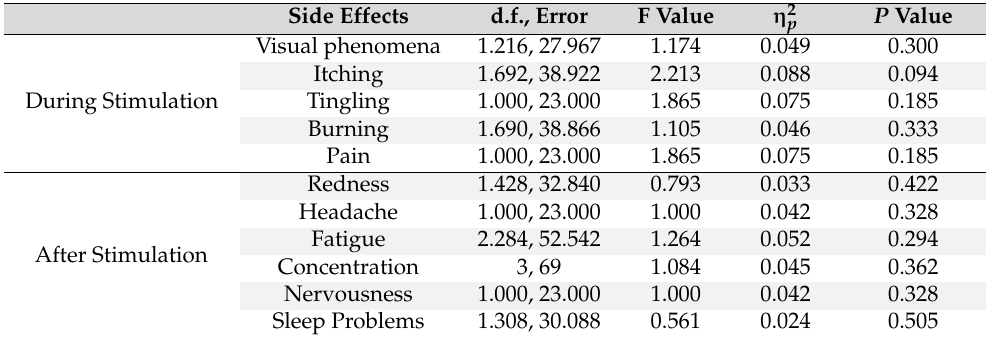
Table 5. Side effect ratings of the participants, ANOVA results. The results showed no significant effect for any of the side effects during or within 24 h following